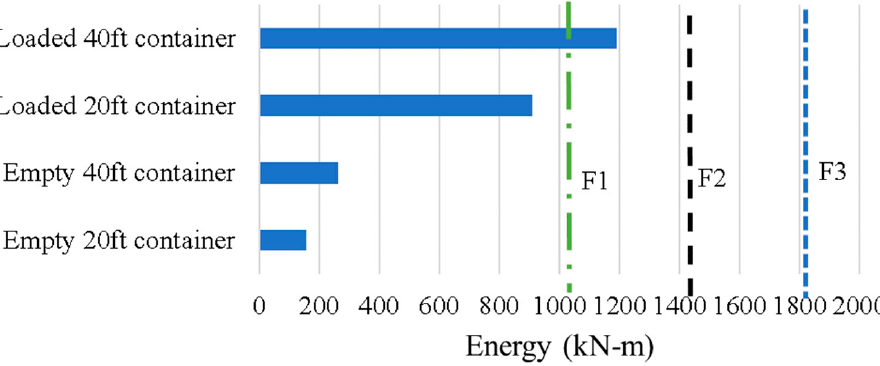
Figure 19. Energy absorption compared with the energy from shipping container impacts.